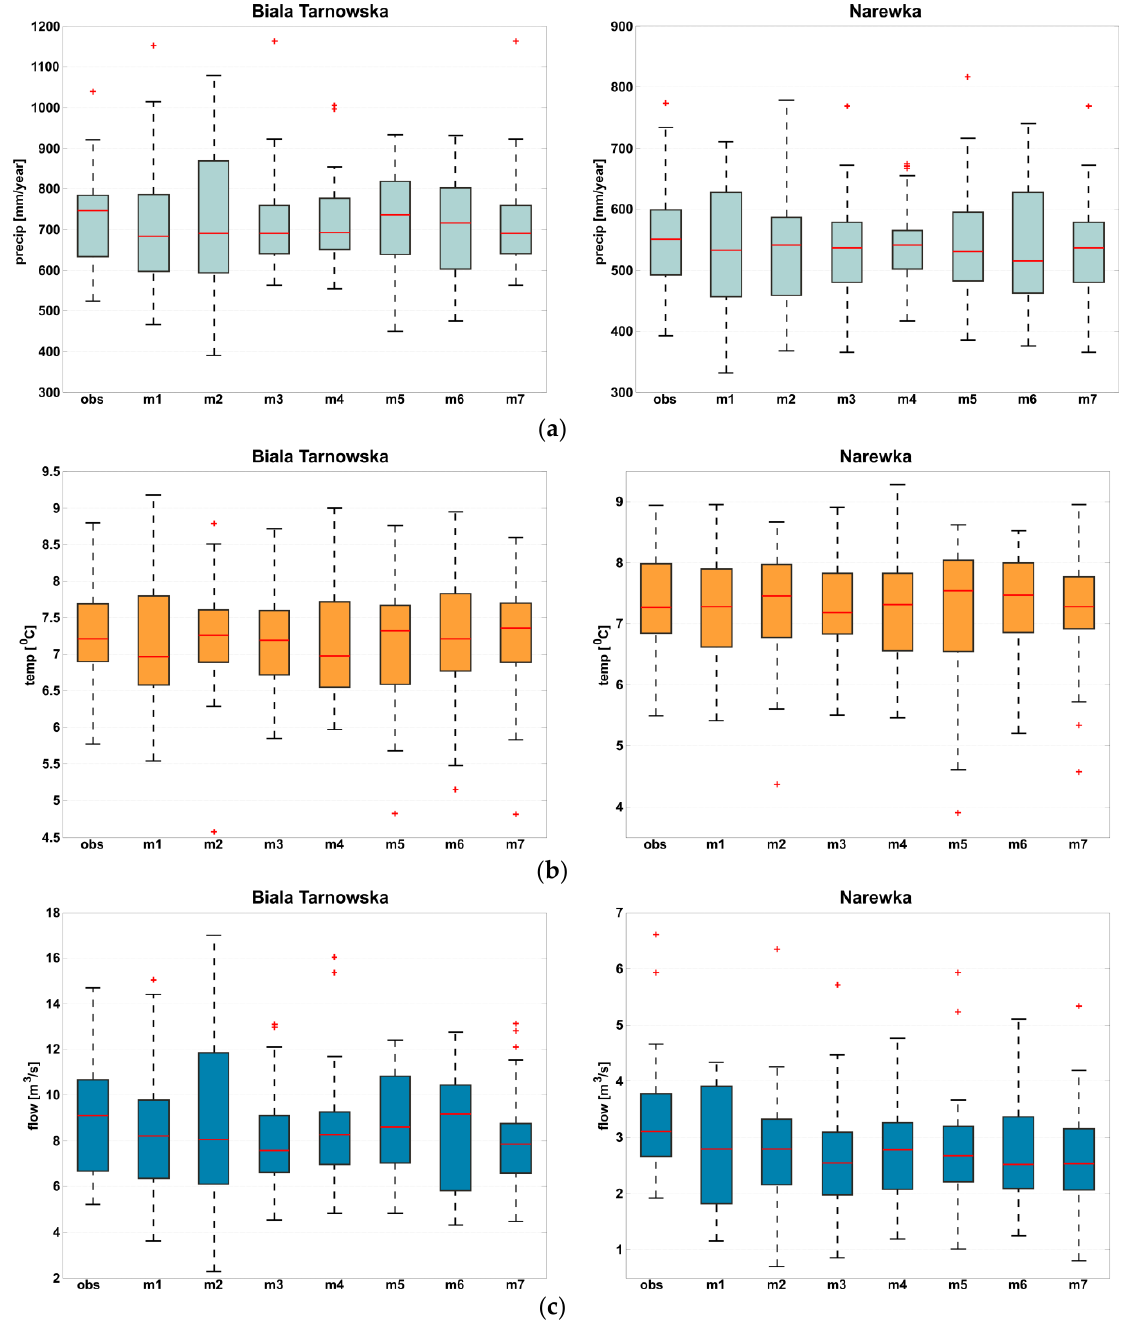
Figure 4. Comparison of simulated (seven climate models denoted as m1, m2, m3, m4, m5 m6 and m7) and observed (obs) annual sums of precipitation ( a ), annual mean air temperature ( b ) and annual mean flow ( c ). In each box, the central red mark denotes a median from seven climate model simulations, the edges of the box are the 25th and 75th percentiles, the whiskers extend to the most extreme data points not considered as outliers, and outliers are plotted individually in the form of red crosses; Biała Tarnowska-panels on the left, Narewka-panels on the right.